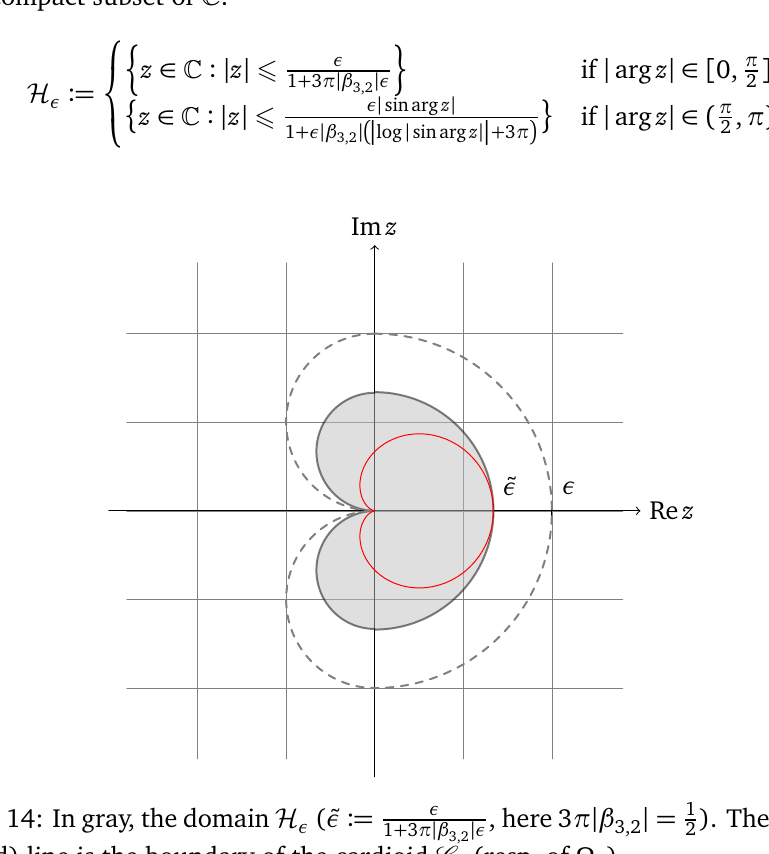
Figure 14: In gray, the domain H ε (˜ ε : = dashed) line is the boundary of the cardioid C